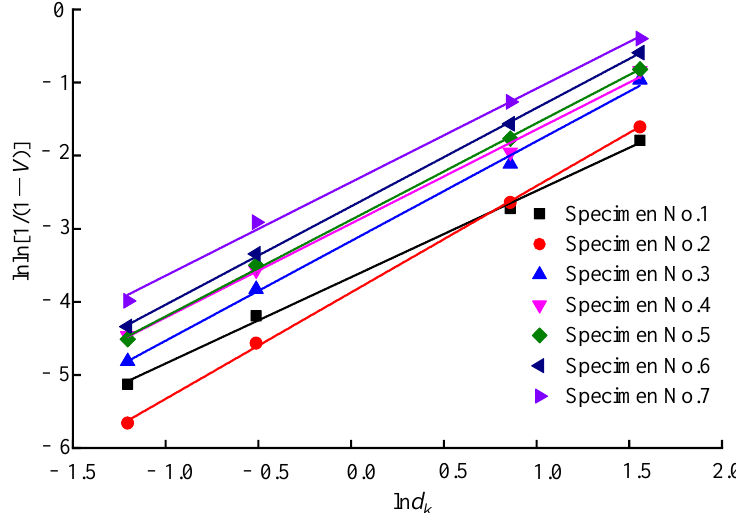
Figure 8. Hard coal crushing particle size distribution curve. Figure 8 and Table 3 show that the double logarithm lnln [1/(1 − V )] is linearly related